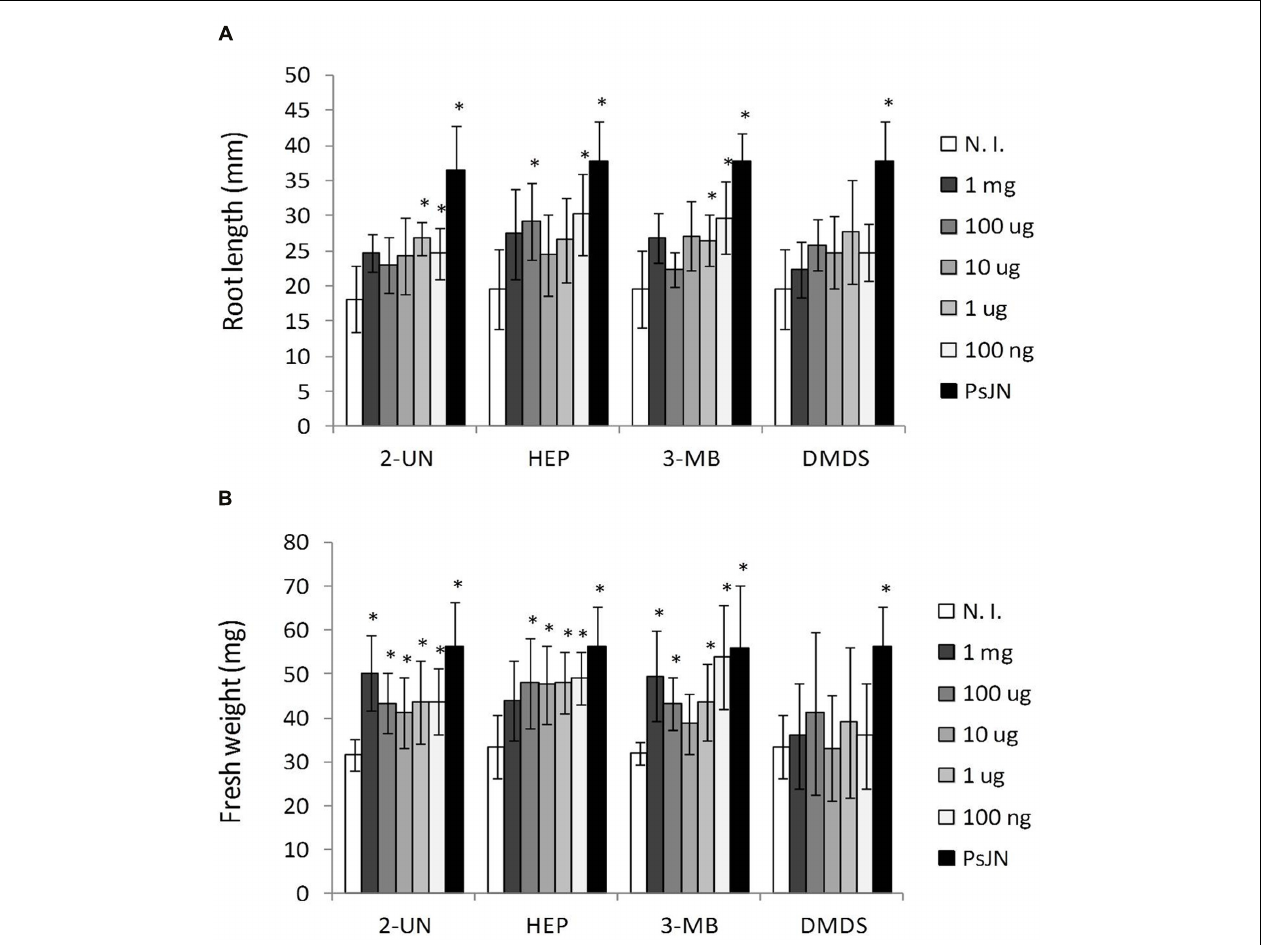
FIGURE 5 | Arabidopsis thaliana growth stimulation by different amounts of individual volatile compounds emitted by P. phytofirmans PsJN. Root growth (A) and fresh weight (B) were determined for A. thaliana col-0 grown in vitro MS 1 / 2 agar medium without bacterial inoculum, and in the presence of different amounts of volatile compounds added per plate. Tested compounds were 2-undecanone (2-UN); 1-heptanol (1-HP); 3-methyl-butanol (3-MB); or dimethyl disulphide (DMDS) at the indicated amounts. Growth parameters were registered at 21 DAS. Columns show mean values, and the error bars indicate standard deviations from experiments with 24 plants analyzed for each compound concentration. Asterisks indicate statistically significant differences from the control (N. I.) treatment within each compound (One way ANOVA Tukey’s HSD tests; p <